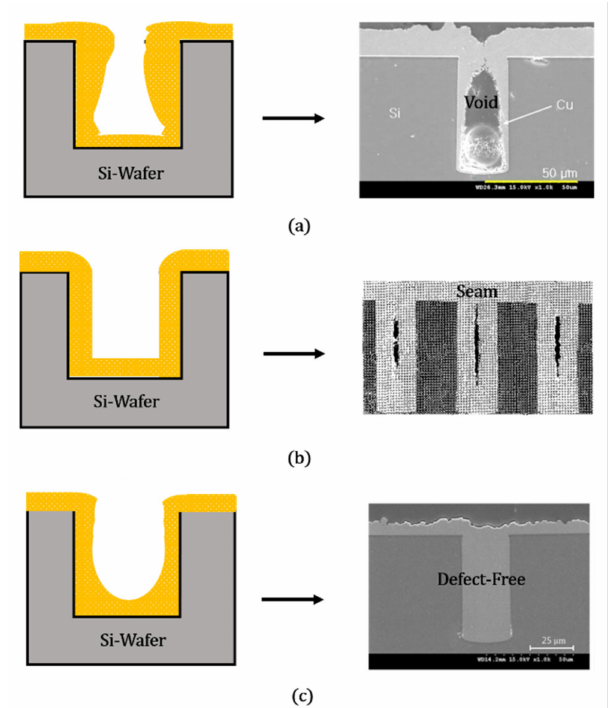
Figure 8. Schematic illustration of ( a ) sub-conformal [44], ( b ) conformal [45], and ( c ) super-conformal filling